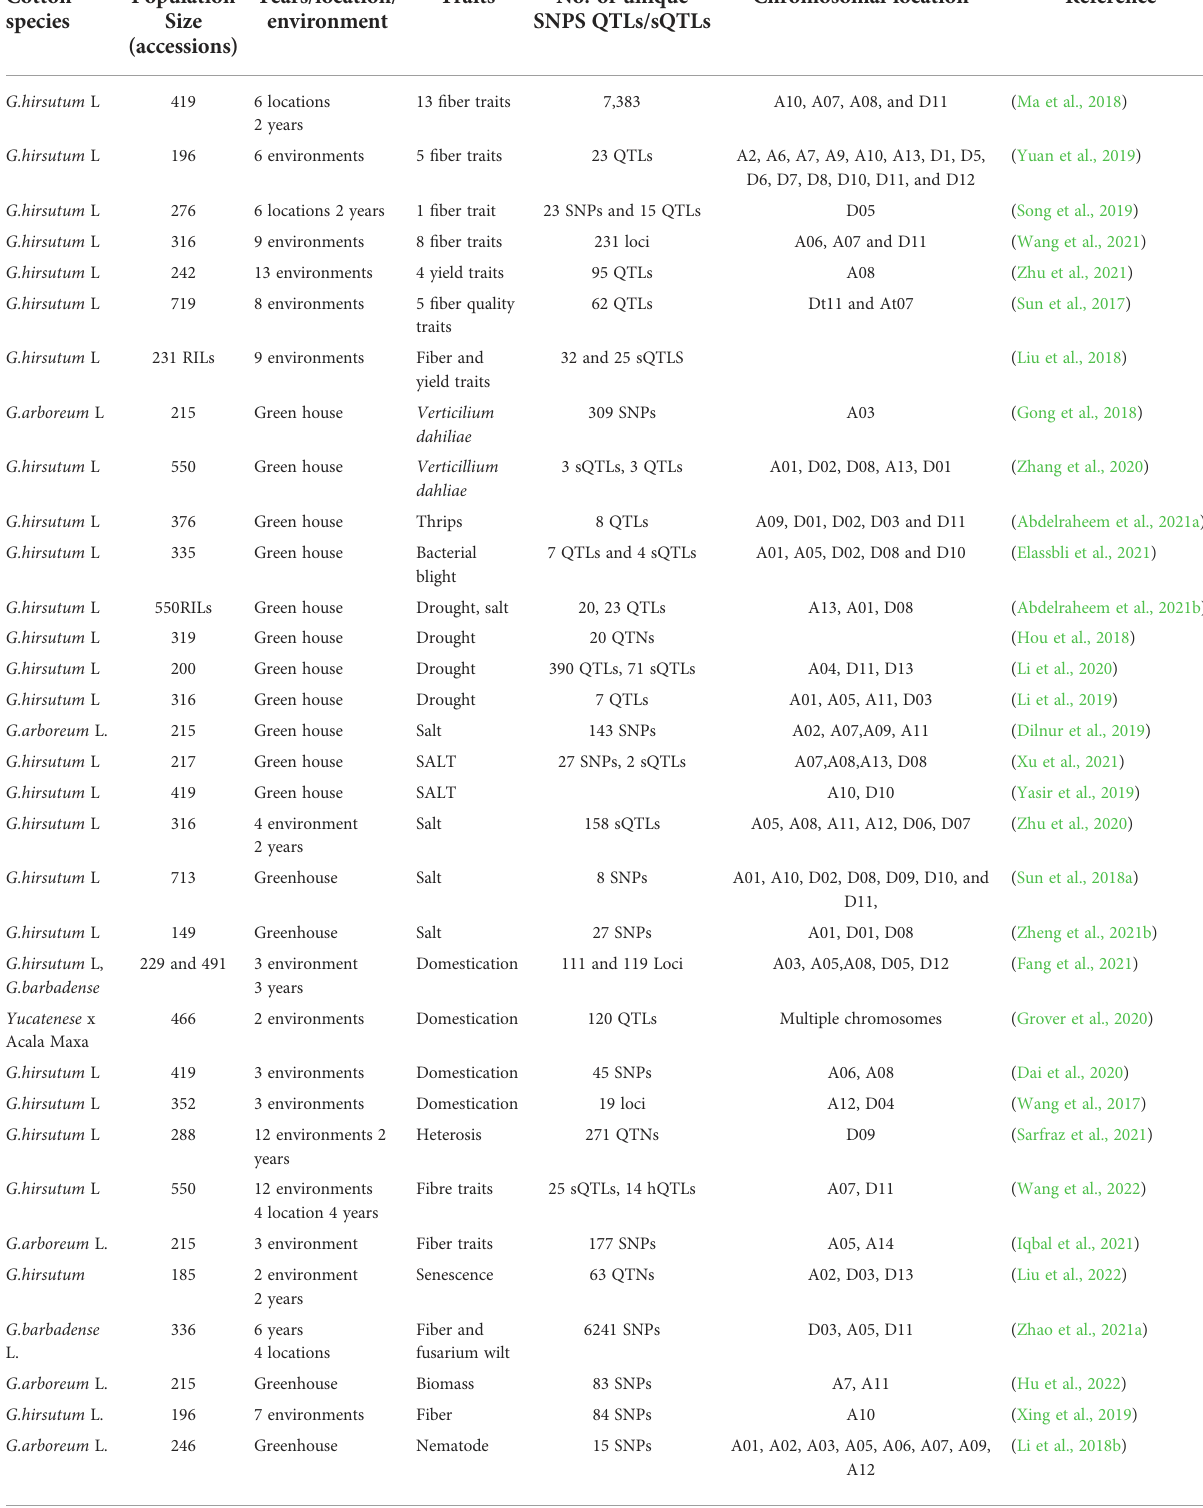
TABLE 1 A summary of GWAS aimed at identifying SNPs/QTLs/Genes or quantitative trait nucleotides QTN, that contribute to cotton improvement. Cotton